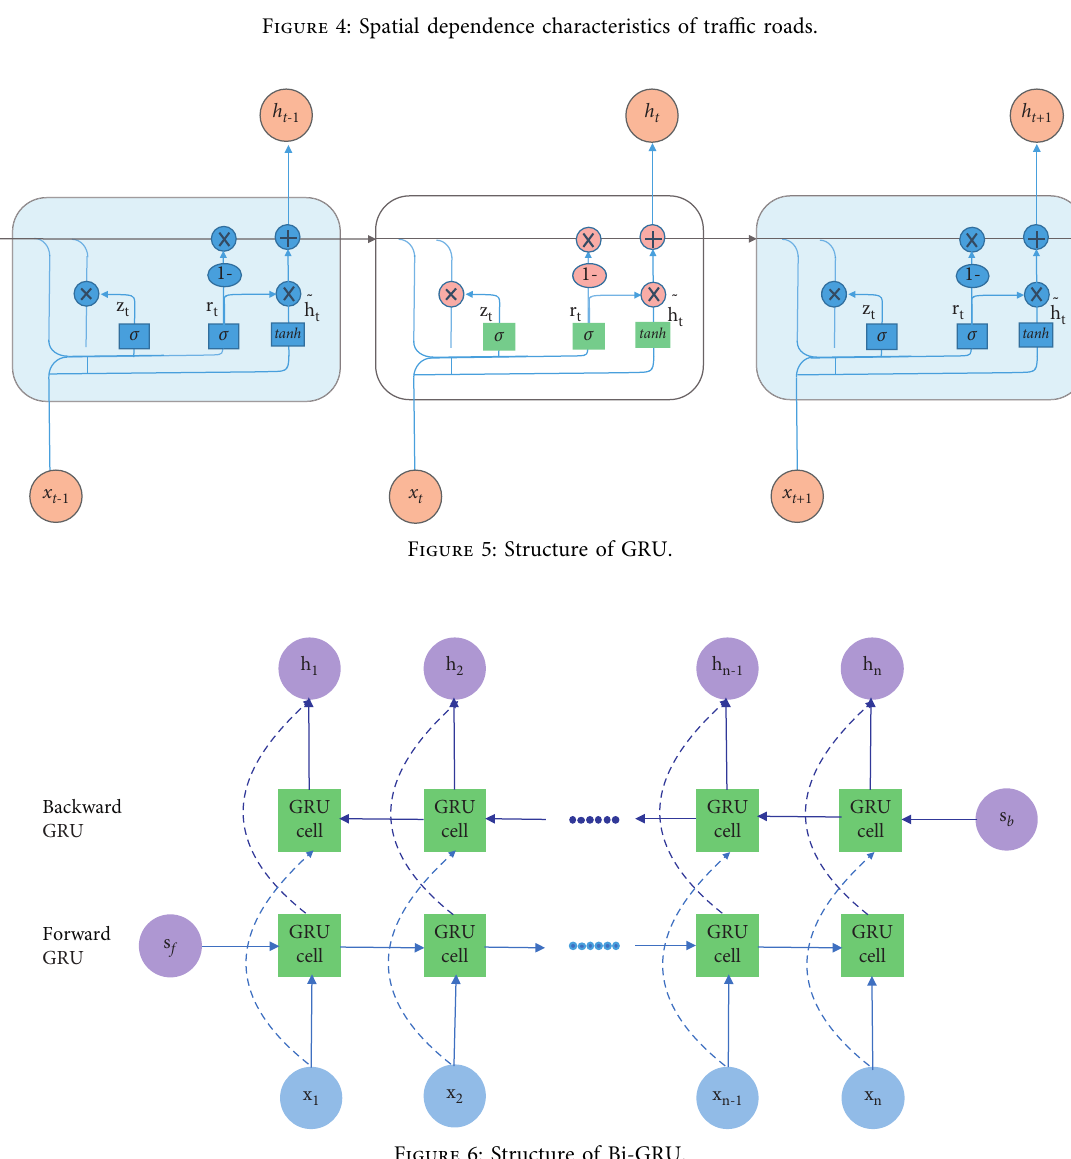
Figure 6: Structure of